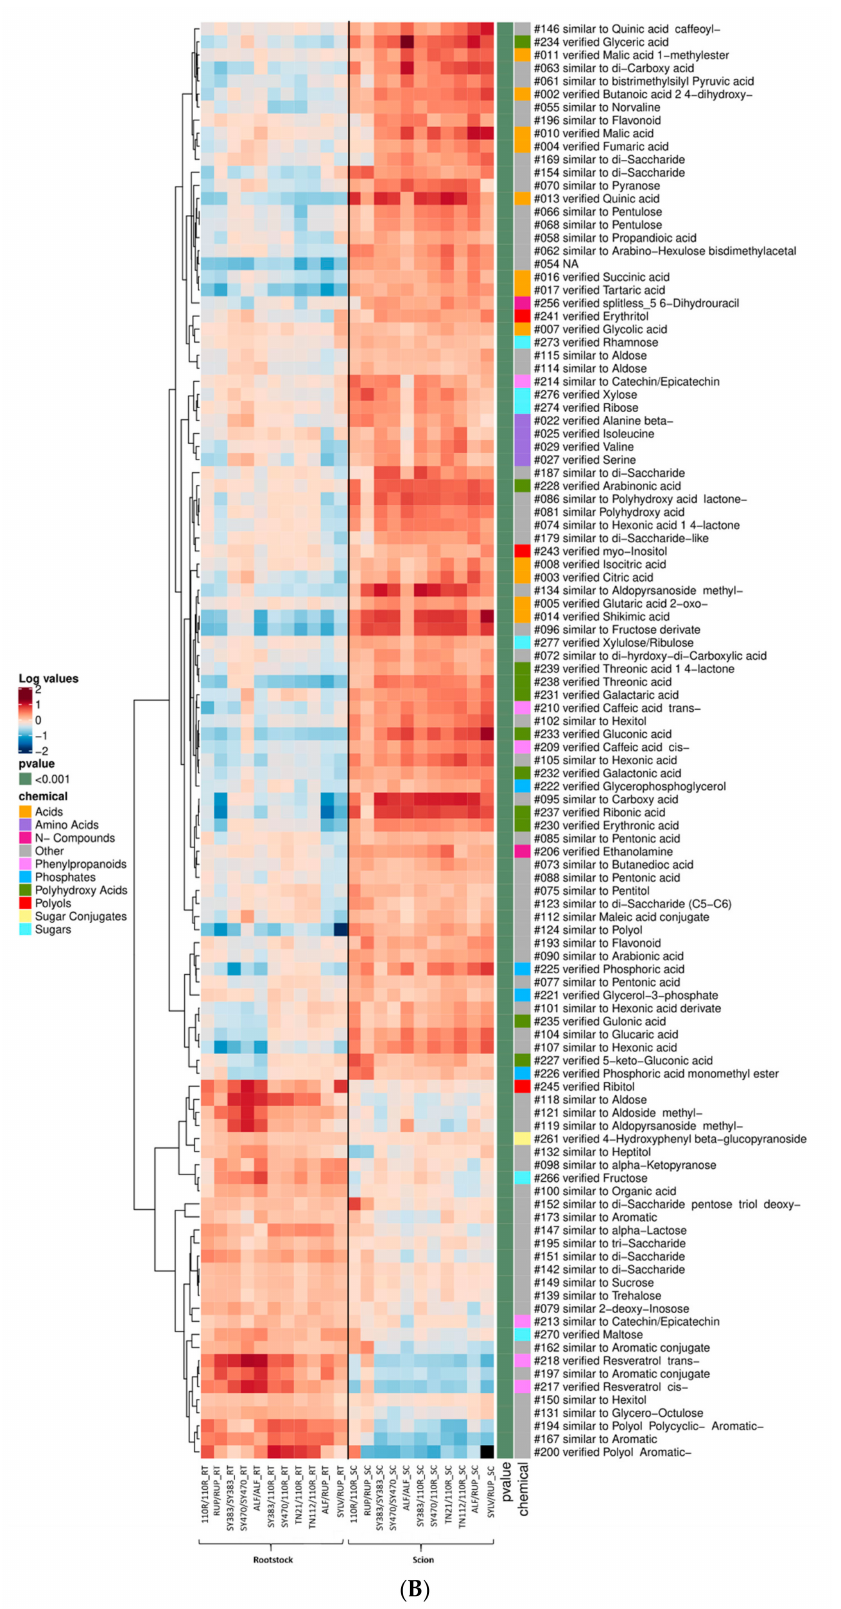
Figure 5. Heatmap clustering analysis of scion vs. rootstock at 5–6 months after grafting: ( A ) in the phloem exudate ; ( B ) stems datasets. Phloem exudate and stems metabolites found increased or decreased in at least 80% of the scion and